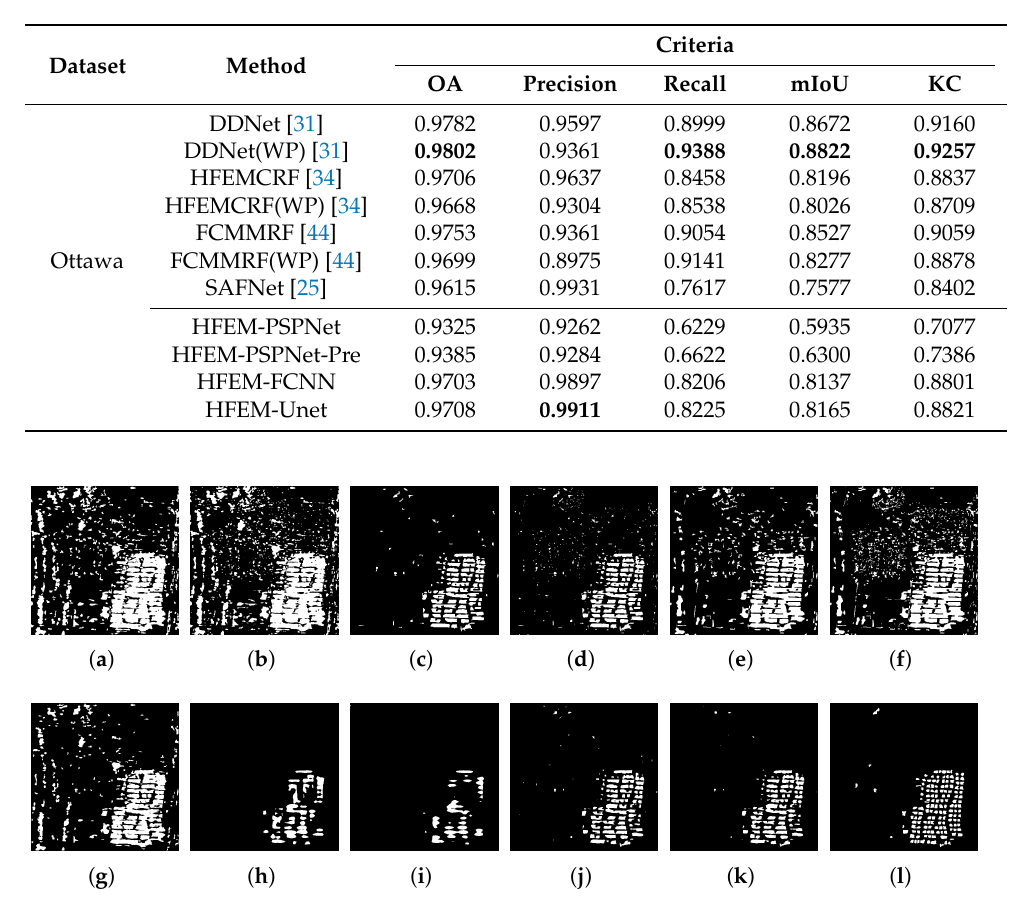
Figure 15. The results of Experiment 1 using Tongzhou dataset. ( a ) DDNet. ( b ) DDNet(WP).